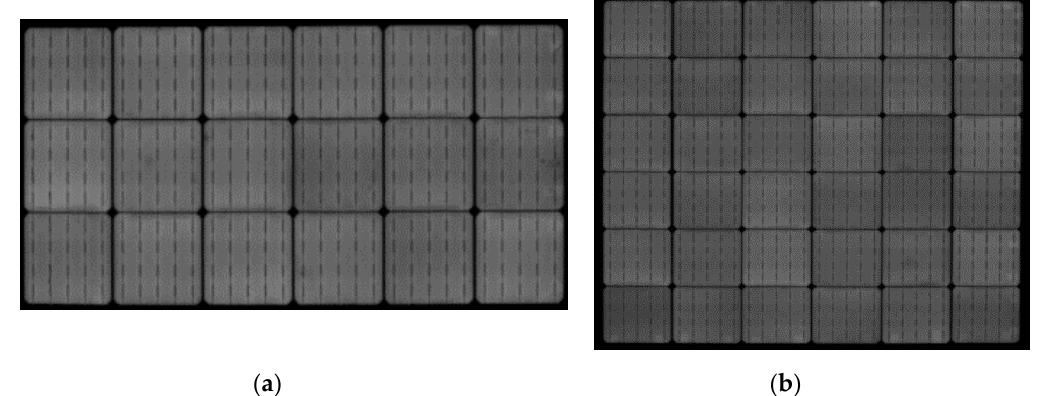
Figure 8. Electroluminescence images obtained at normal incidence shooting for: ( a ) Terracotta; and ( b ) Texturing Roof Tile.